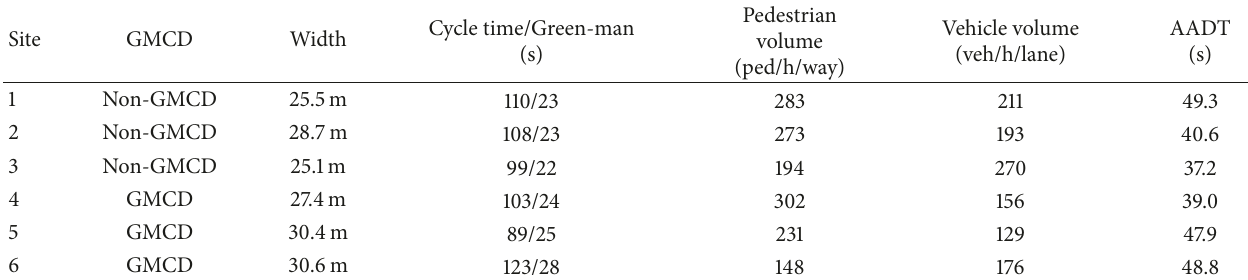
Table 1: Statistics of the 6 survey